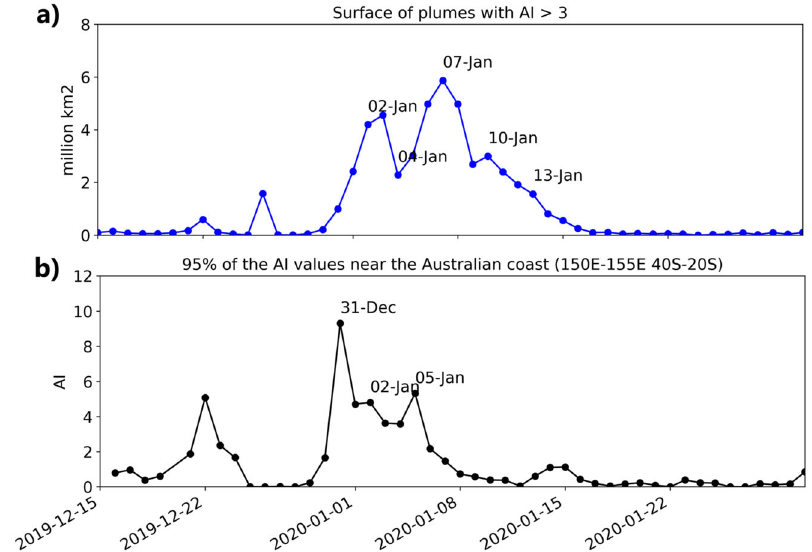
Fig. 1 Time evolution of the smoke clouds as observed by TROPOMI satellite instrument. a Time evolution of the total surface covered by the aerosol plumes with Absorbing Aerosol Index AAI>3 over the southern hemisphere. This threshold is chosen to follow the evolution of the main plume that was characterized by values of AI up to 10. The plumes show a sharp gradient in AI at the borders, where the AI value rapidly decreases, allowing to clearly de fi ne the boundaries of the aerosol cloud. b 95th percentile of the aerosol close to the Eastern Australian coastal region (150° – 155 E 20° – 40° S) where the extreme PyroCb activity took place. The main aerosol injections occurred between 30 and 31 December 2019, producing a plume that reached a fi rst maximal spatial extension on the 2 January 2020, and between 4 and 5 January, when a second event produced an additional aerosol cloud that, combined with the fi rst one, caused a total absorbing aerosol coverage that reached a maximum of 6 millions km 2 of extension on the 7 January. The plumes then gradually dissipated and diluted, decreasing in their AI values, until the third week of January, when the AI signal from the aerosol clouds is no more visible by TROPOMI, with the exception of few bubbles of con fi ned aerosol (see next